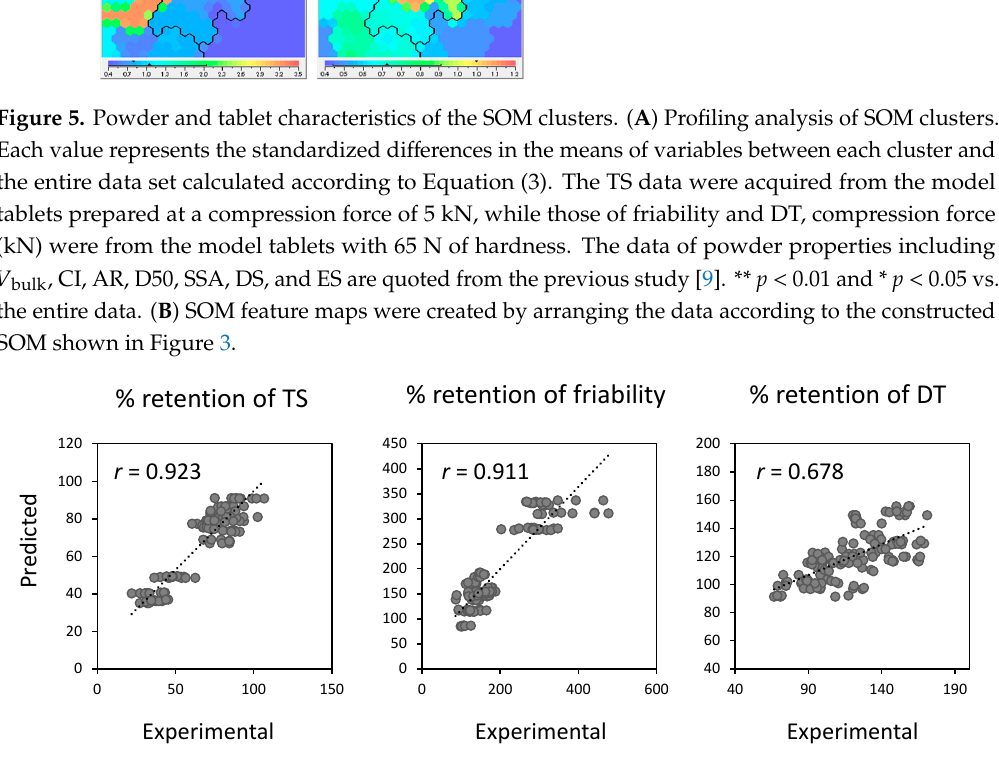
Figure 6. Scatterplots of experimental vs. predicted values. The predicted variables were obtained from the regression models estimated using the ENET regression technique. Table 2. Crucial powder properties affecting % retention of TS estimated using the ENET technique.